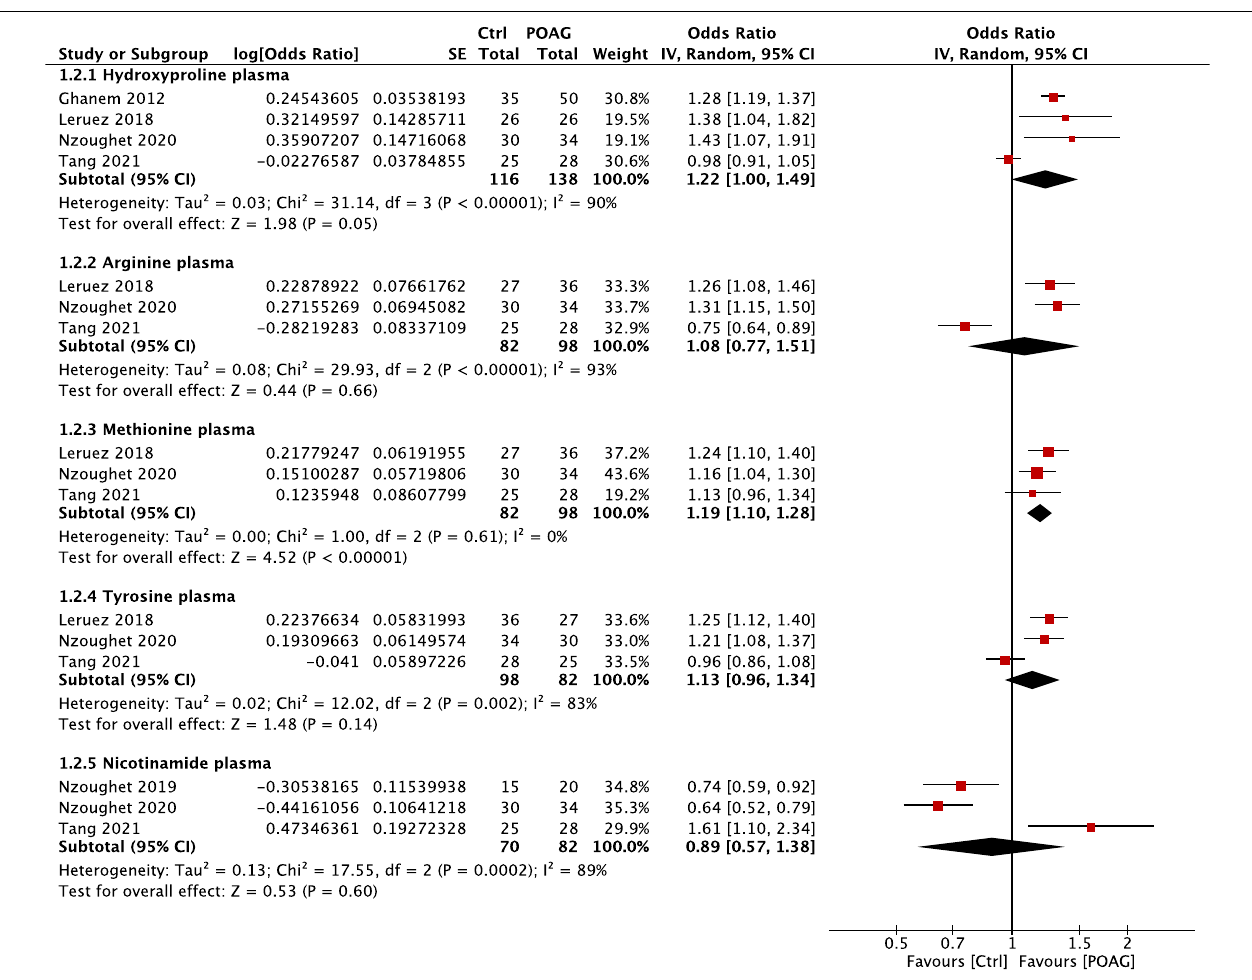
FIGURE 4 | Forest plot of the metabolites in the plasma of patients with POAG compared to controls using a random-effect model. Odds ratio (OR) and 95% confidence intervals (95% CI) were given. The position of the red squares and the horizontal black lines correspond to OR and 95% CI of each study, respectively. The size of the square stands for the weight of the study. The overall OR was displayed by the black diamond, the width of which shows the overall 95% CI of per metabolite. The I 2 and p- value for heterogeneity were displayed, and the p -value for each metabolite is shown after the test for overall